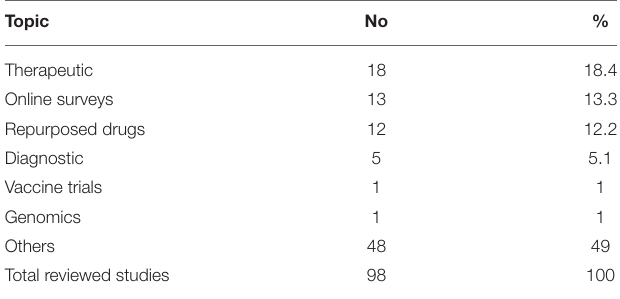
TABLE 1 | Frequency of clinical trial phases reviewed by FMASU REC from April to October